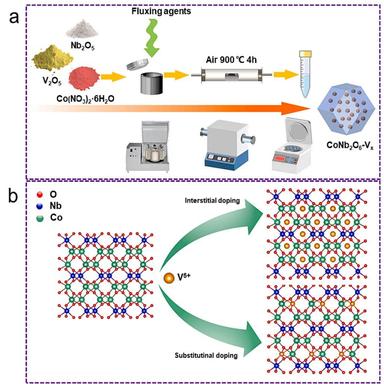
(a) Schematic diagram for the preparation of CNO-Vx nanoparticles; (b) Crystal structure of CNO and its structural changes after doping.